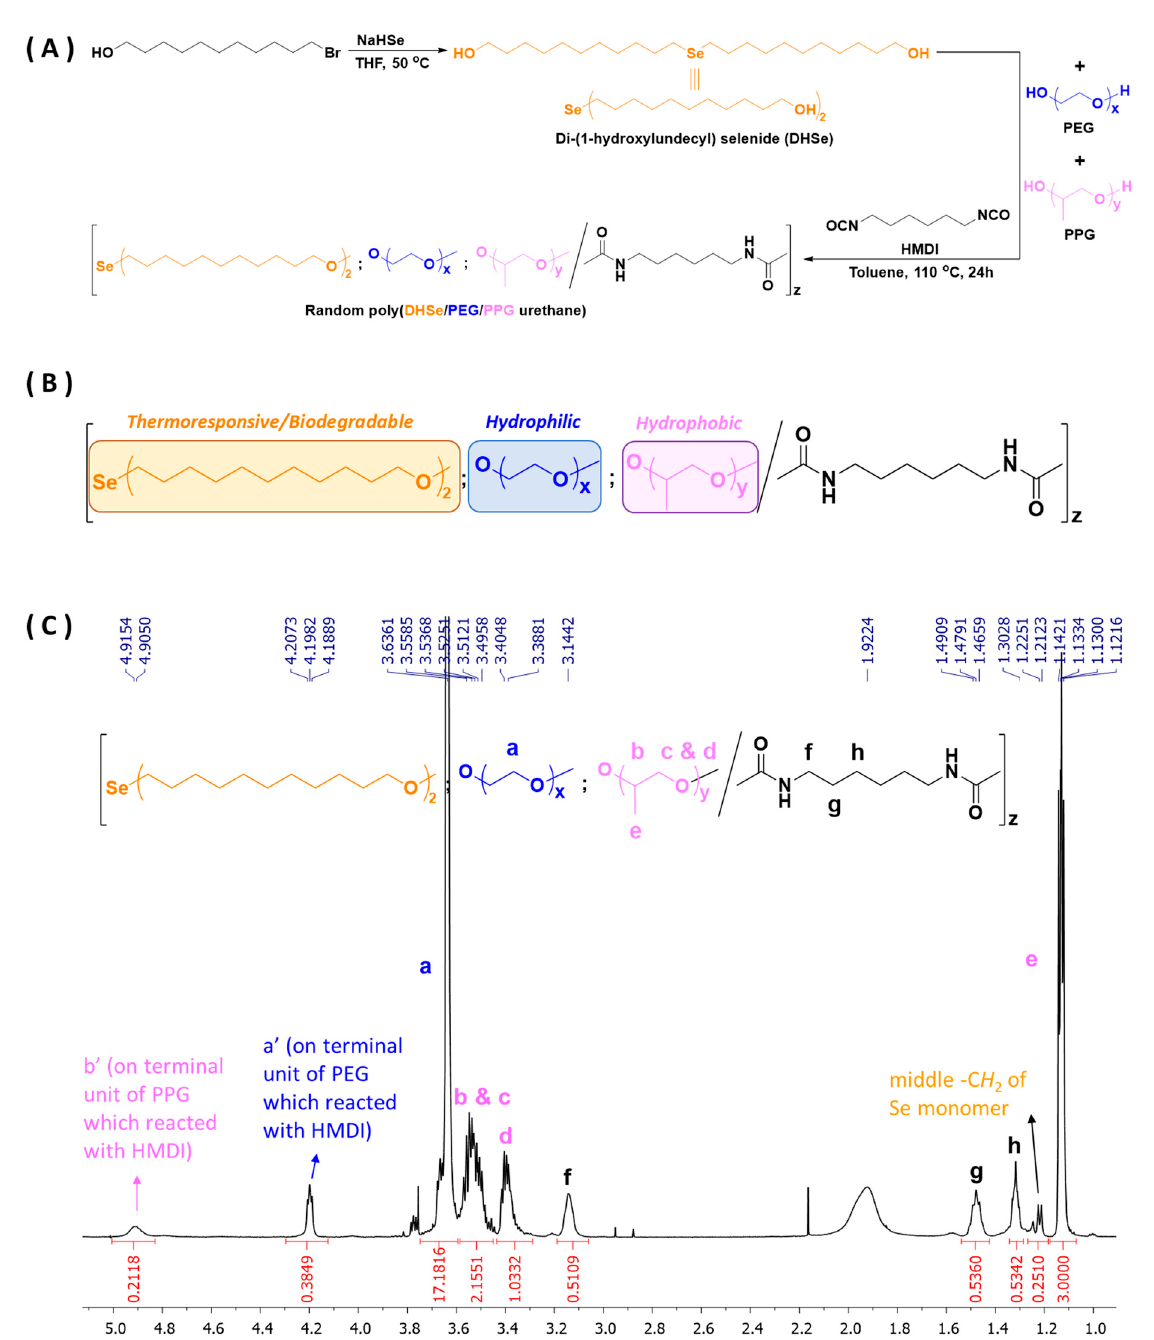
Figure 1. Synthesis and characterization of poly(DHSe/PEG/PPG urethane): ( A ) synthetic scheme; ( B , C ) structure and 1 H NMR spectra of copolymer. Table 1. Molecular characteristics and thermal properties of poly(DHSe/PEG/PPG urethane).